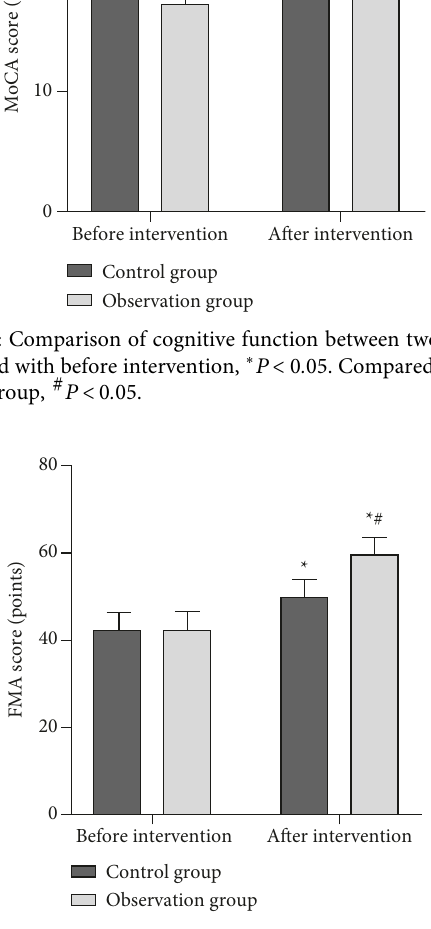
Figure 3: Comparison of motor function between two groups. Compared with before intervention,